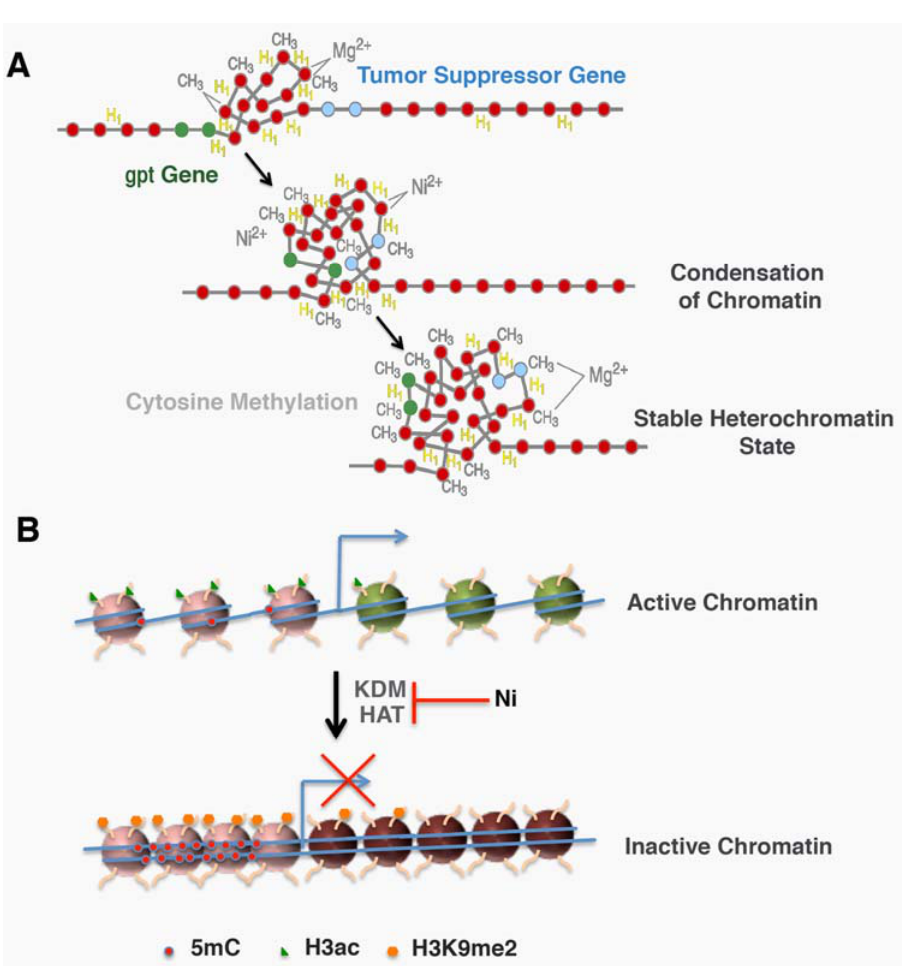
inactive chromatin by inducing repressive mark H3 lysine 9 dimethylation (H3K9me2) and DNA methylation (5mC) as well as inhibiting H3